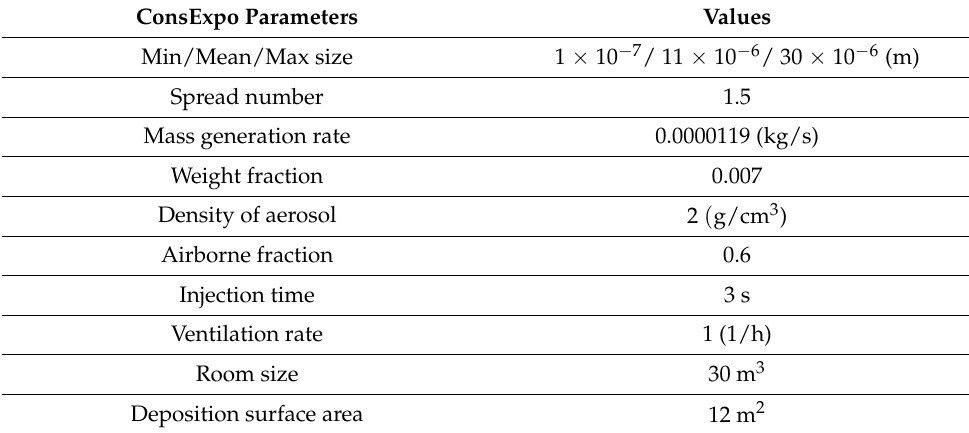
Figure 2. Results of measurement for mass fraction by aerosol diameter ( a ) and experimental and fitted cumulative mass fraction curve by aerosol diameter ( b ). The aerosol size distribution was measured as a repeated method. Mean of PSD for aerosol was converted to a Rosin–Rambler curve to obtain the aerosol information, such as mean of aerosol diameter and spread number. Table 1. ConsExpo spray model parameters.